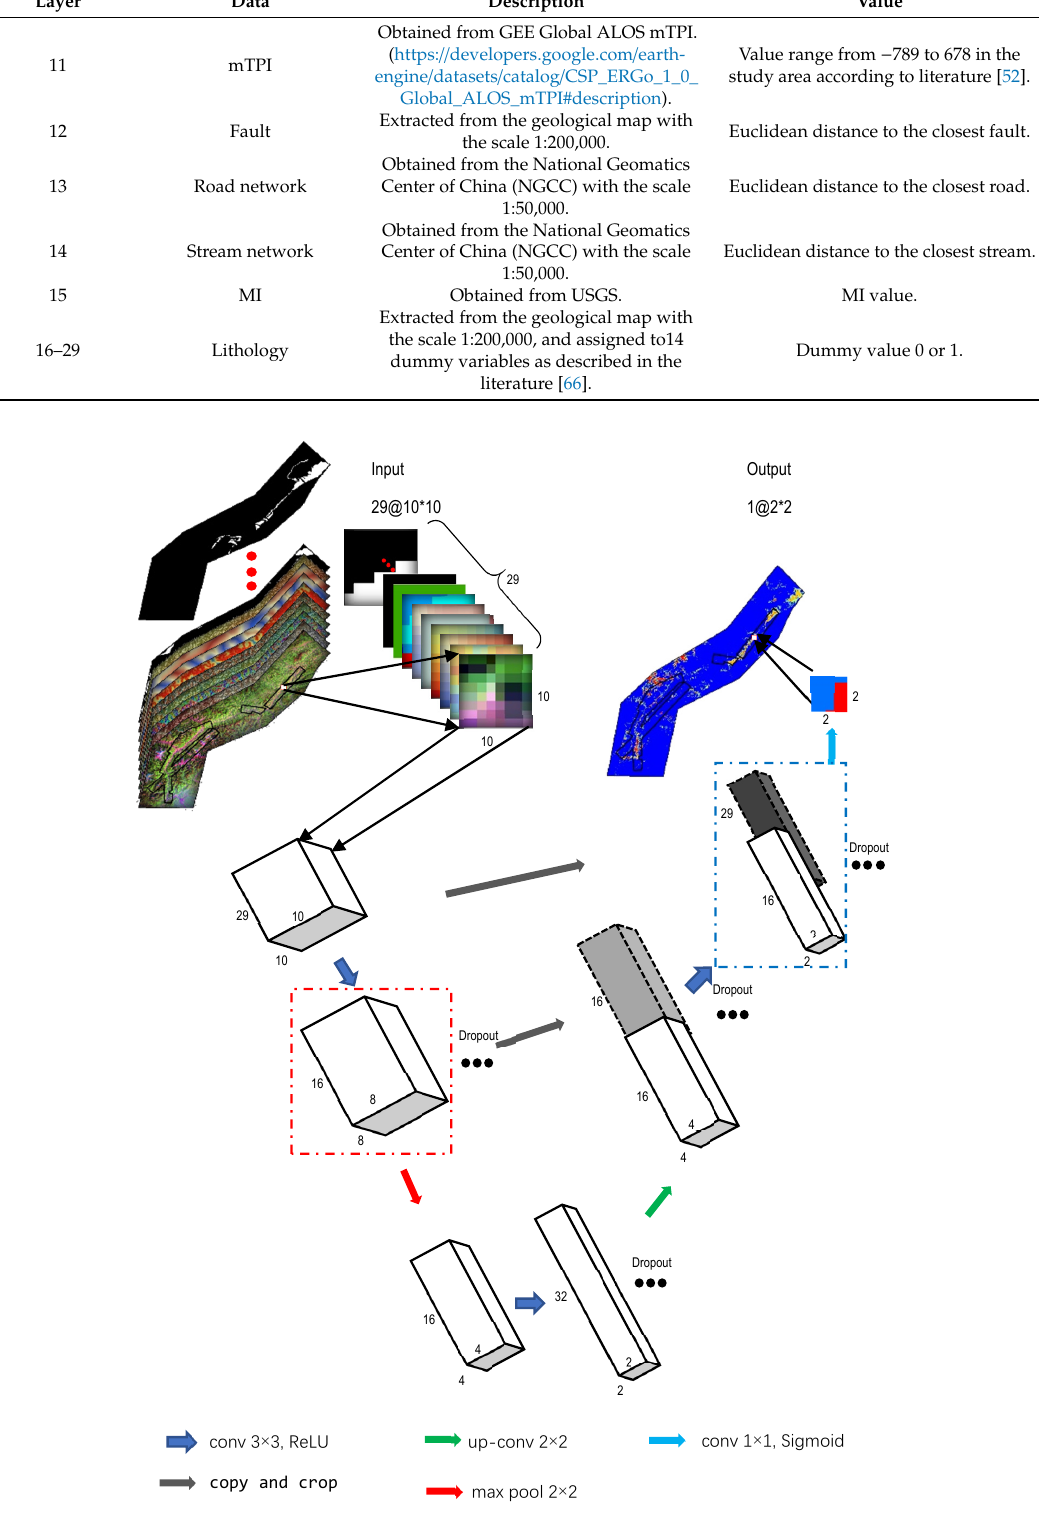
Figure 9. U-net like model architecture for post-earthquake landslide susceptibility mapping (LSM). Figure 9. U ‐ net like model architecture for post ‐ earthquake landslide susceptibility mapping (LSM). Each box corresponds to a multi-layer feature map. The number of layers and the x-y-dimension are Each box corresponds to a multi ‐ layer feature map. The number of layers and the x ‐ y ‐ dimension are shown on the box. The colored arrows denote the di ff erent operations. The red dotted polygon shows the first convolution layer and the blue dotted polygon shows the last convolution